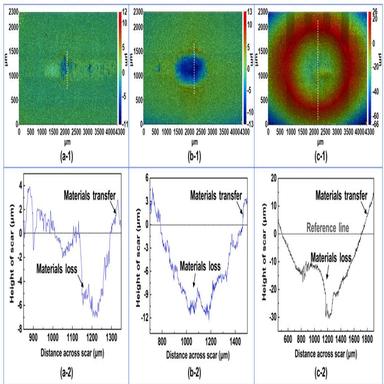
3D morphology and cross-sectional profiles of the worn areas of the claddings with different frequency. (a) Cr-coated cladding tested under 5 Hz; (b) Crcoated cladding tested under 20 Hz; (c) uncoated cladding tested under 20 Hz.